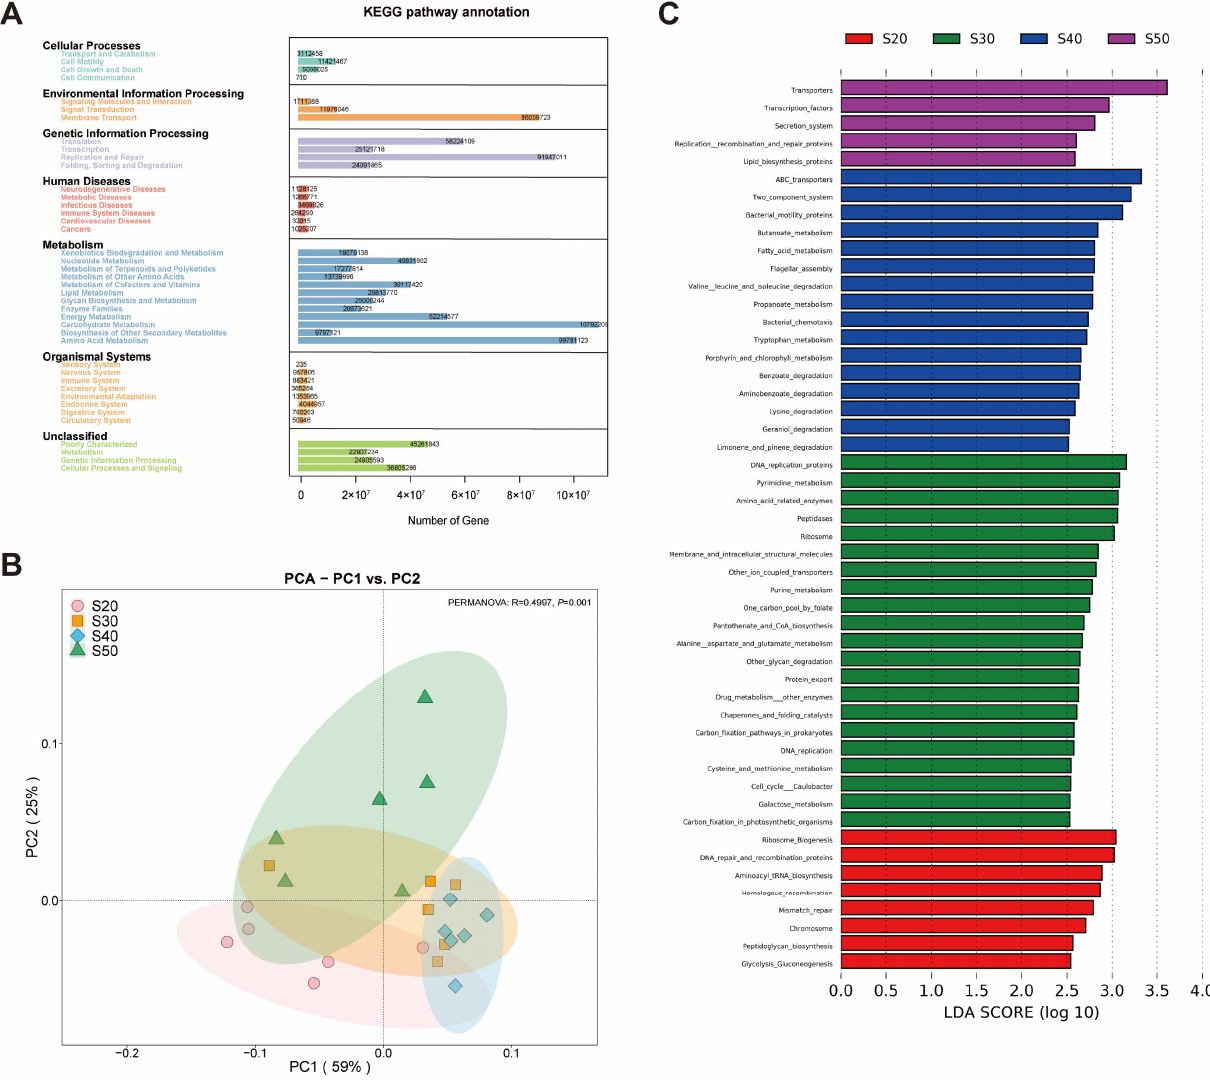
Figure 3. Bacterial function prediction based on the KEGG database via PICRUSt2. ( A ) Statistical histogram of KEGG pathway prediction results based on the 16S gene copy number. ( B ) Principal Component Analysis (PCA) of absolute abundance of functional annotations based on the KEGG database. ( C ) Linear discriminant analysis (LDA) plus effect size of function prediction, LDA score ≥ 2.5 with p < 0.05 was marked. Treatments: S20, S30, S40 and S50 are ~14% CP, SP proportion (% of CP) 20, 30, 40 and 50,